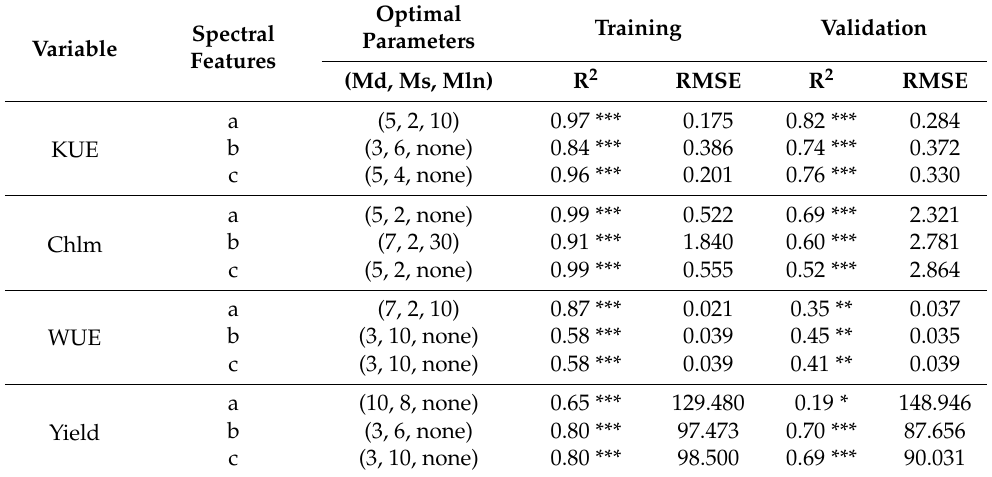
Table 7. Results of a decision tree model based on different features extracted from hyperspectral data. Optimal Spectral Parameters Variable Features